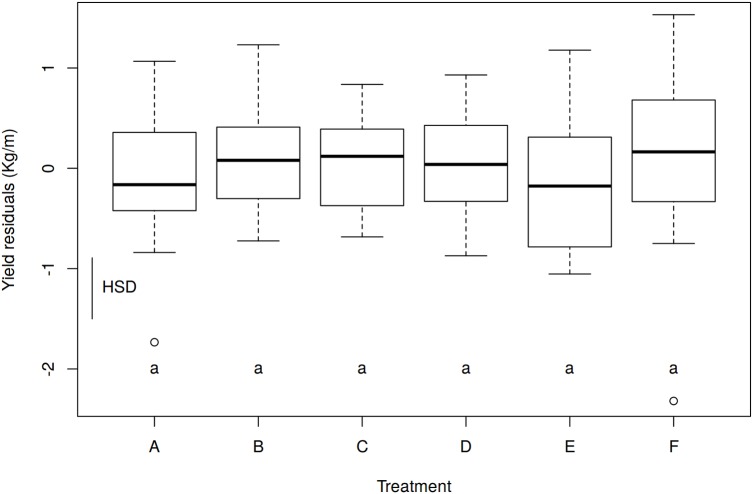
Effect of treatments on yield (kg/m) with the residuals of the Block Pair ANOVAs.Boxes show the 25th and 75th percentiles. Lines in the boxes show the median values. Df, degrees of freedom = 102; F-value = 0.5914; p-value = 0.7065; HSD, honestly significant difference = 0.6073 kg/m; columns with the same letter do not differ significantly from each other at p ≤ 0.05 (HSD).